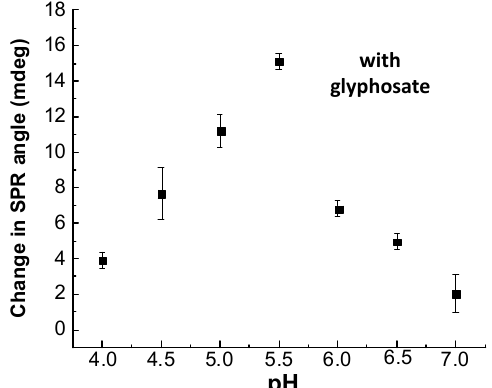
Figure 9. Role of pH (4.0 to 7.0) in the change in SPR angle in the case of CS/ZnO film cross-linked by GA in the presence of 0.30 μ M glyphosate (dead time corresponds to around 156 s between injection and the cell output). Experimental conditions: ( i ) first, injection of a non-buffered solution at a given pH adjusted by 0.01 M HCl and 0.01 M NaOH without glyphosate into the SPR system to obtain a steady-state baseline, followed by the injection of the glyphosate solution at the same pH, and the change in SPR angle corresponding to the effect of glyphosate with respect to the baseline before glyphosate injection; ( ii ) same procedure at another pH value.